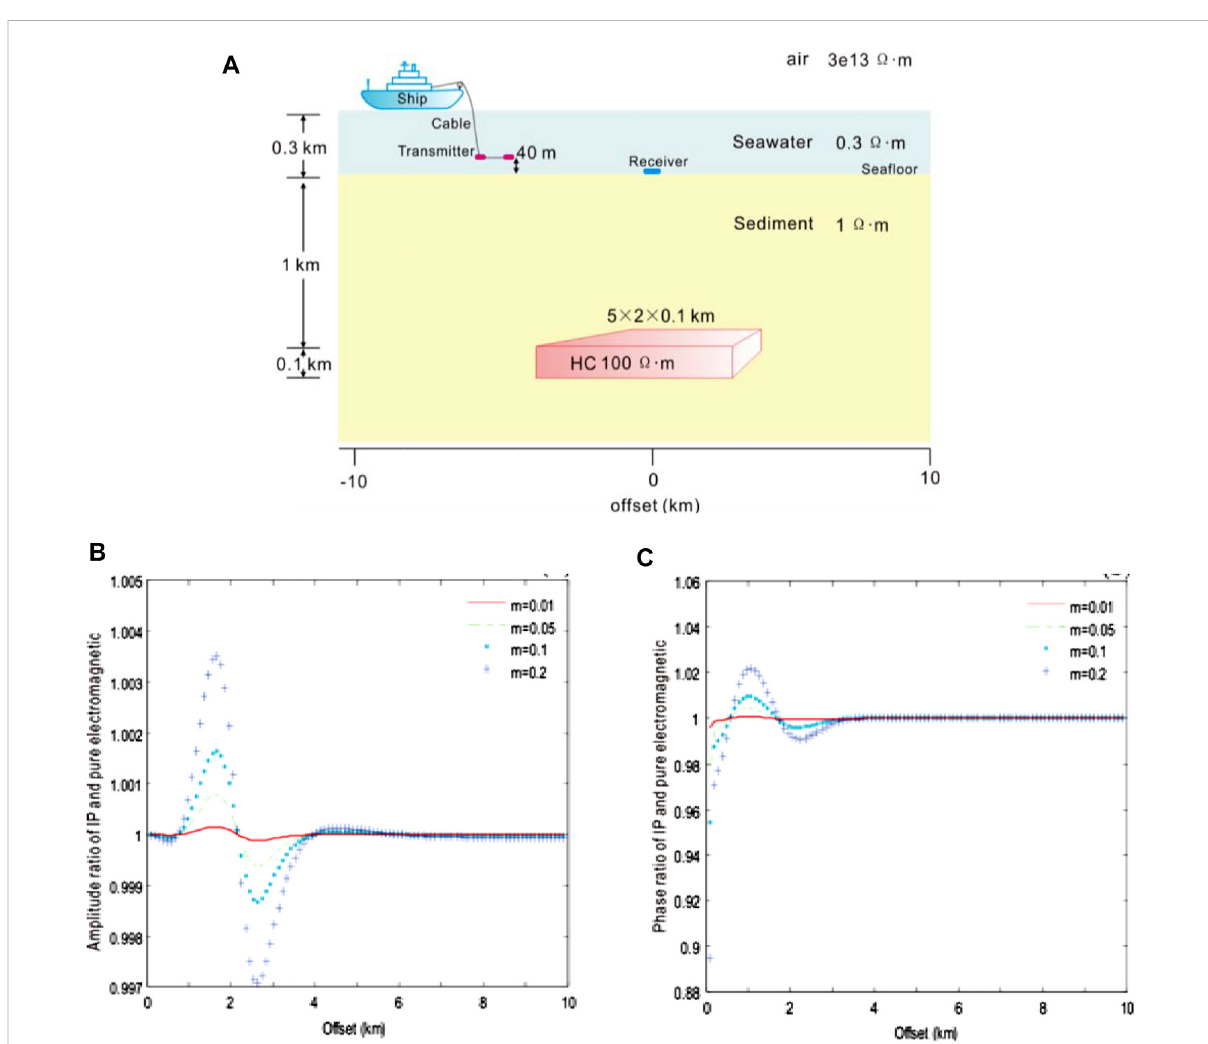
FIGURE 12 Amplitude and phase ratio of CSEM with the IP and pure electromagnetic fi eld to the SNP model of various polarizability m = 0.01 (red), 0.05 (green),0.1(blue),and0.2(lightblue),respectively. (A) Geoelectricmodelofsubmarinehydrocarbonswithion-inducedpolarizationinthe3Dmarine CSEM, (B) the ratio of amplitude, and (C) the ratio of